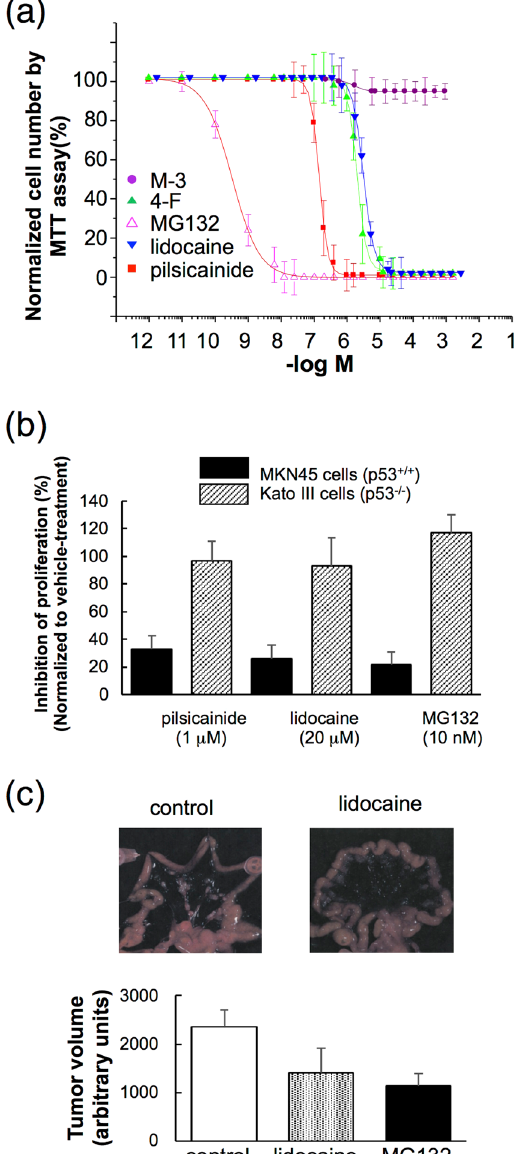
Figure 4. Effects of LAs on cancer cells. ( a ) Effects of LAs on the proliferation of MKN45 cells. MKN45 cells were cultured for 24 h in the presence of MG132, pilsicainide, lidocaine, 4-F or M-3. Proliferation of MKN43 was estimated by MTT assays. ( b ) Effects of LAs on the proliferation of MKN45 and Kato III cells cultured for 24 h in the presence of MG132 (10 nM), pilsicainide (1 μ M) and lidocaine (20 μ M). ( c ) In the in vivo experiments, lidocaine significantly decreased the proliferation of MKN45 cells dispersed among mouse mesenchymal cells to a similar extent as